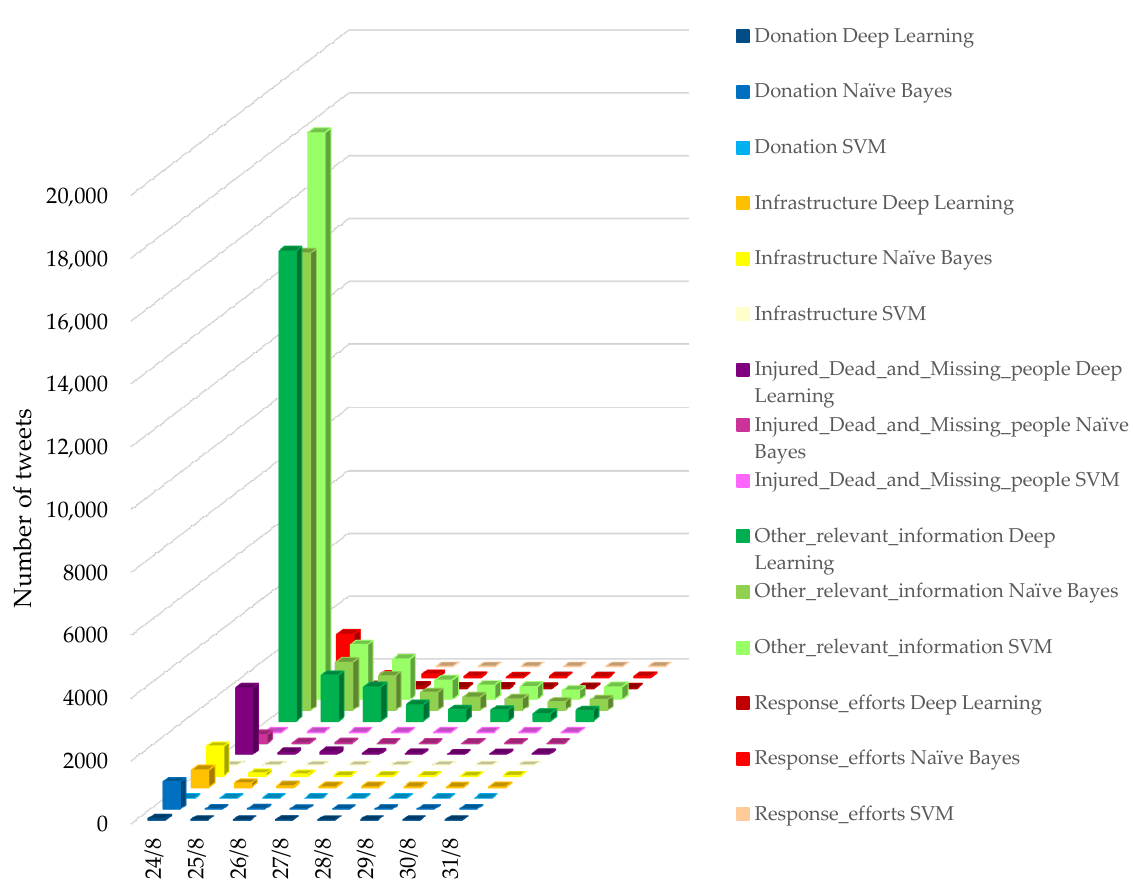
Figure 5. Distribution of classified tweets in 5 classes on different days, a week after the earthquake (August 24) in the three — Naive Bayes, SVM, and deep learning — classification algorithms.